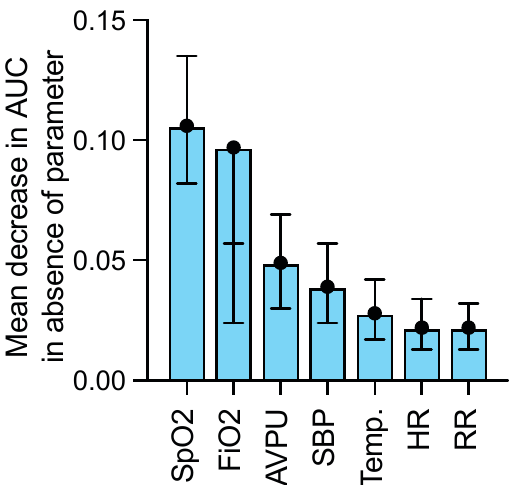
Figure 4. Relative contribution of each variable of NEWS for the detection of sepsis. Conditional permutation importance [10] for random forest models was used to estimate the relative contribution of each variable of NEWS to the area under the curve of the model. Relative contribution of each variable: O2 saturation (SpO2) 0.106, fractionated inspired O2 (FiO2) 0.097, alert/verbal/pain/unresponsive mental state (AVPU) 0.049, systolic blood pressure (SBP) 0.057, temperature (Temp.) 0.028, heart rate (HR) 0.034, respiratory rate (RR) 0.022.